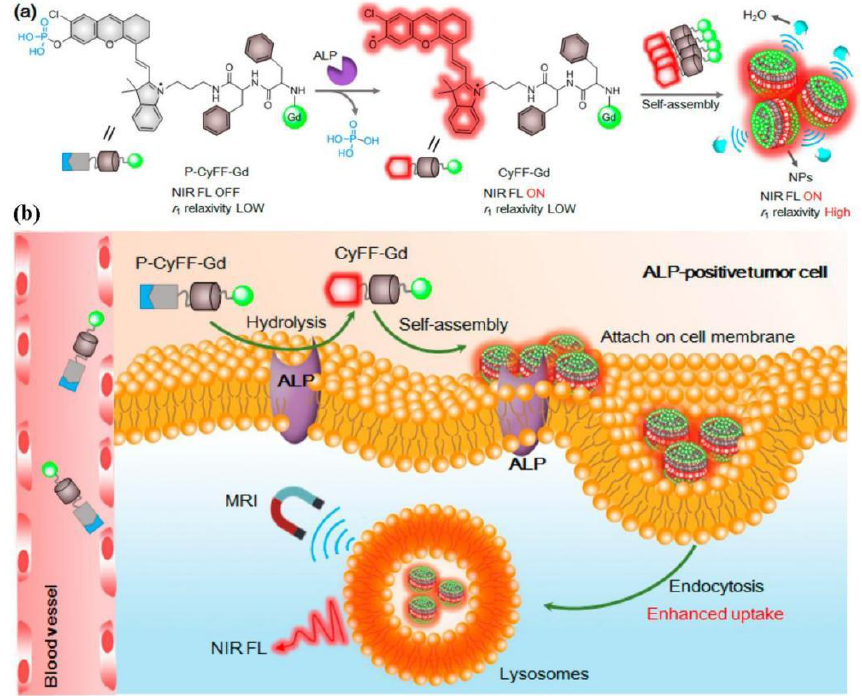
Figure 4. Schematic description of an ALP-activatable NIR fluorescence (FL)/MR bimodal probe for in vivo imaging. ( a ) Chemical structure of P-CyFF-Gd, the ALP-regulated fluorogenic reaction of P-CyFF-Gd, and in situ self-assembly of CyFF-Gd into NPs that displayed enhanced NIR FL and r 1 relaxivity. ( b ) Proposed mechanism of P-CyFF-Gd for NIR FL/MR bimodal imaging of ALP-expressing tumor cells in vivo. Reprinted/adapted with permission from [80]. Copyright 2019, American Chemical Society.